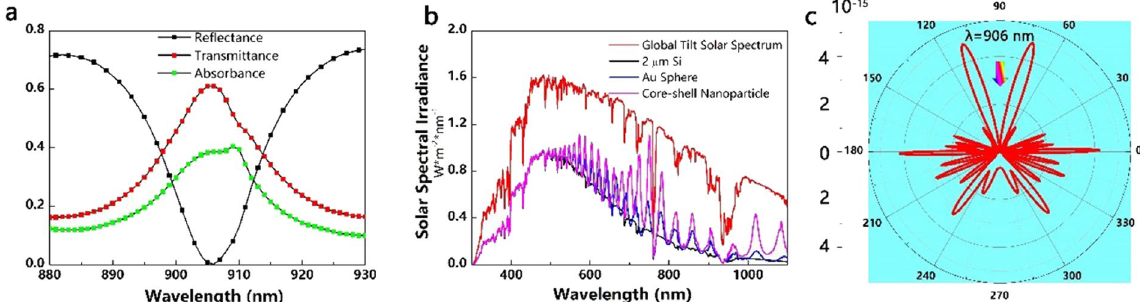
Figure 8. ( a ) Characteristic line shape of a rear-located core-shell nanoparticle on a 2 μ m thick Si ( t = 60 nm, P = 400 nm). ( b ) Global tilt solar spectrum, together with graphs that illustrate the solar energy absorbed in a 2 μ m thick Si film (assuming single-pass absorption and no reflection coating), a 2 μ m thick Si film with a 120 nm Au sphere ( P = 400 nm) located on the rear surface and a 2 μ m thick Si film with a core-shell nanoparticle ( t = 60 nm, P = 400 nm). ( c ) Angular scattering of a core-shell nanoparticle on a 2 μ m thick Si film under 906 nm illumination ( t = 60 nm, P = 400